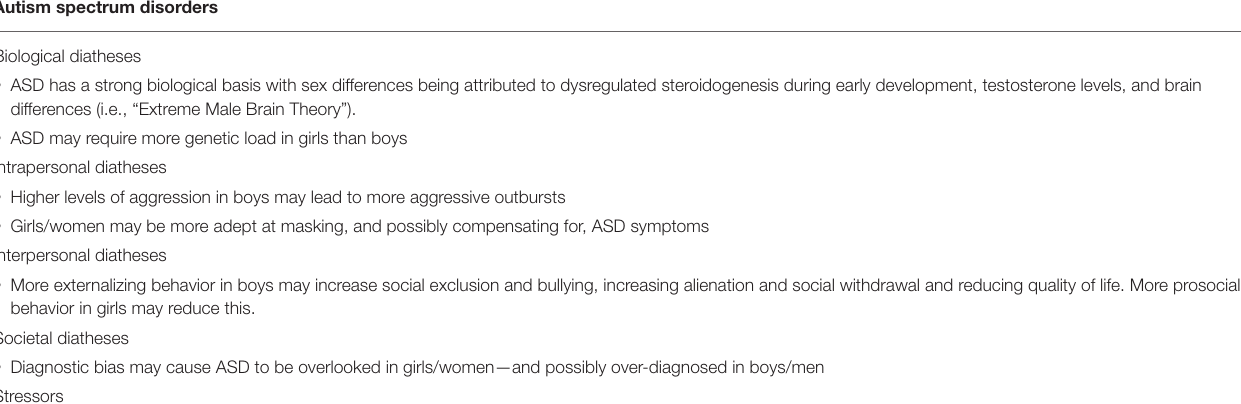
TABLE 4 | Examples of how the diathesis-stress model may account for sex/gender differences in ASD, eating disorders, and PTSD. Autism spectrum disorders Biological